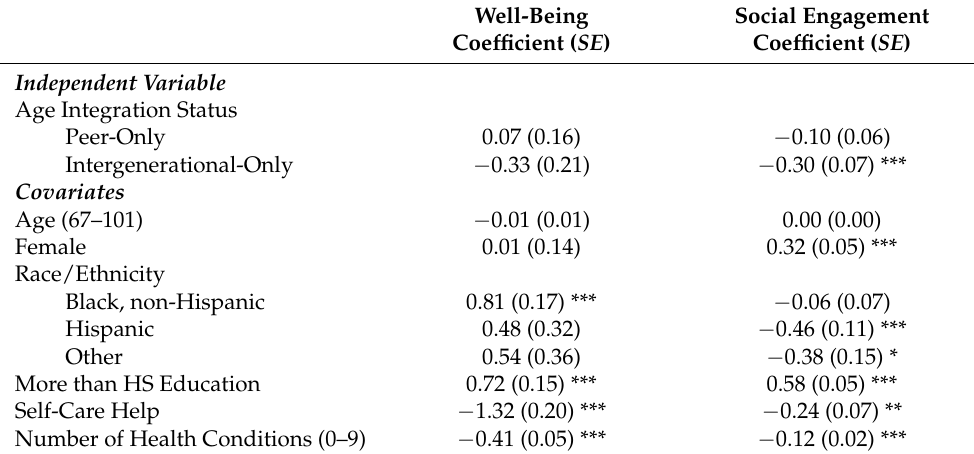
Table 3. Weighted Ordinary Least Squares Regression: Effect of Age Integration Status on Well-Being and Social